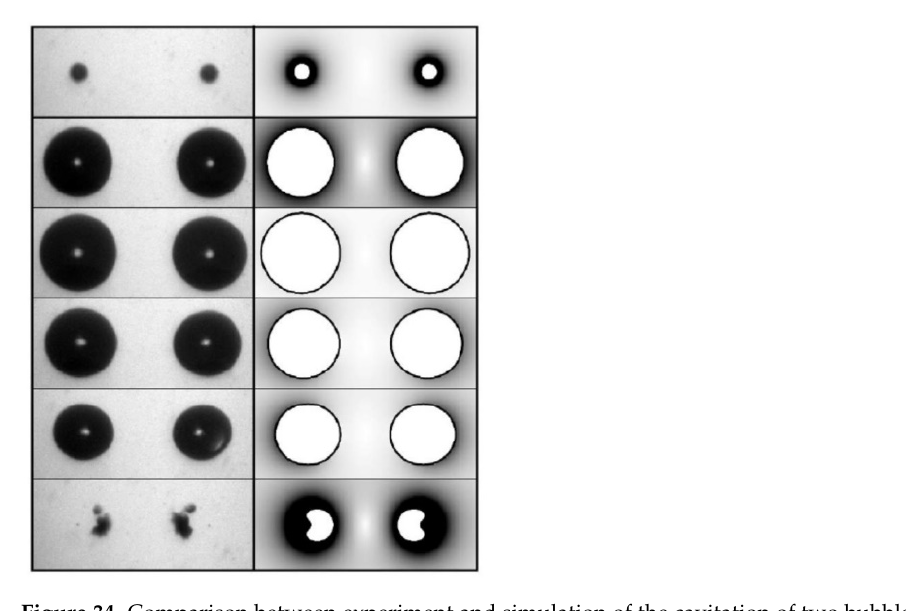
Figure 34. Comparison between experiment and simulation of the cavitation of two bubbles initially separated by 400 µ m [73]. Copyright 2006, with the permission of AIP